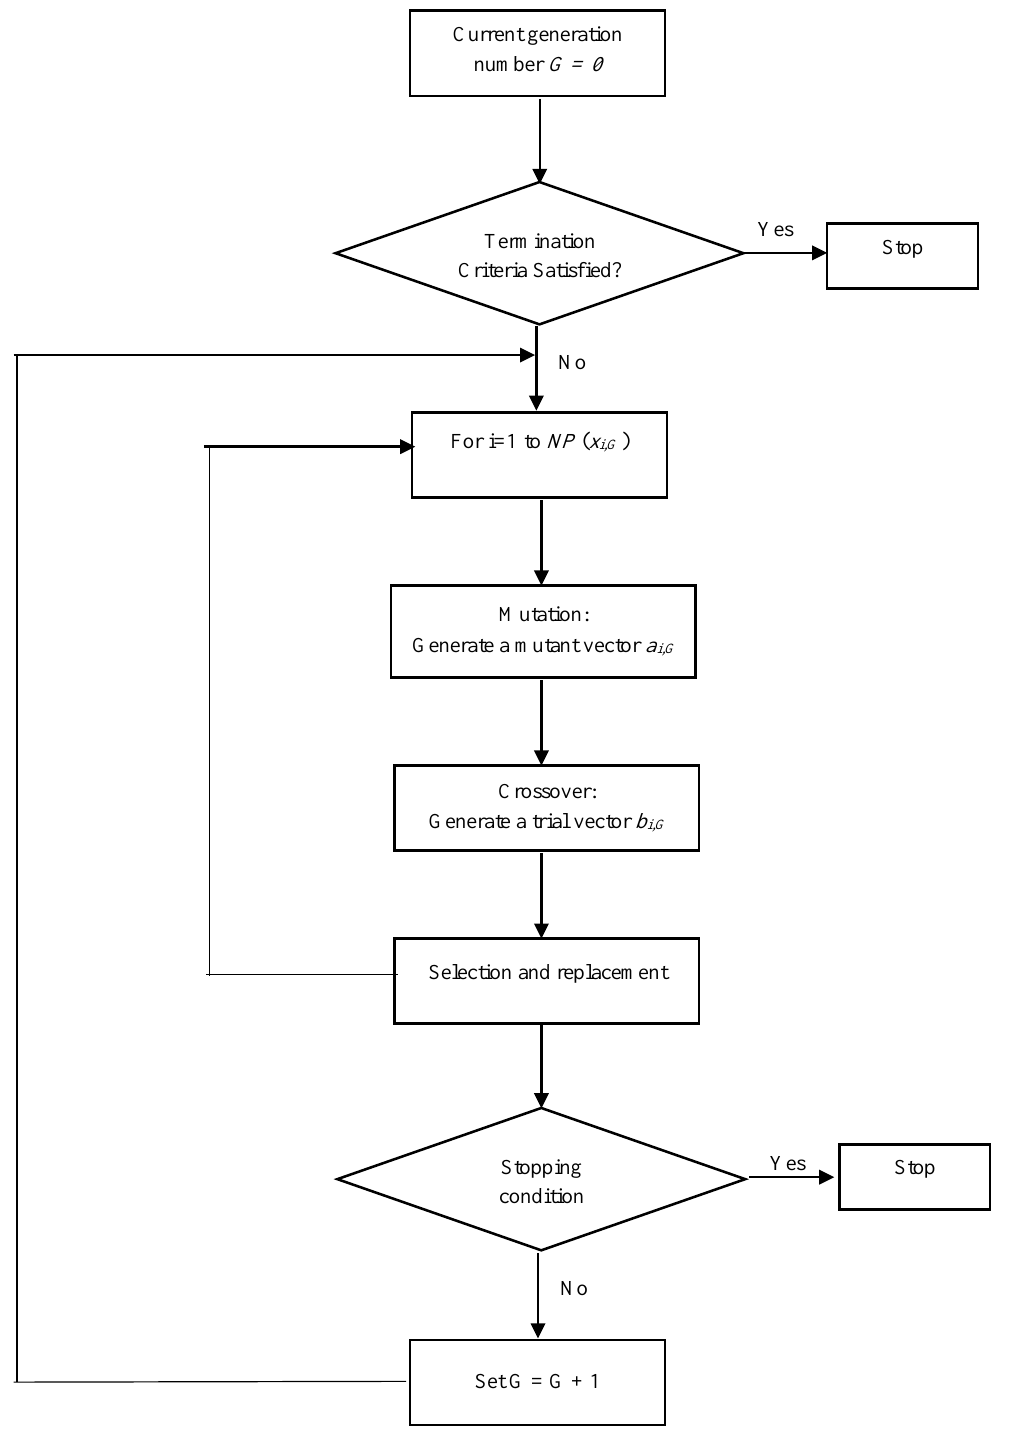
Fig. 1. DE standard